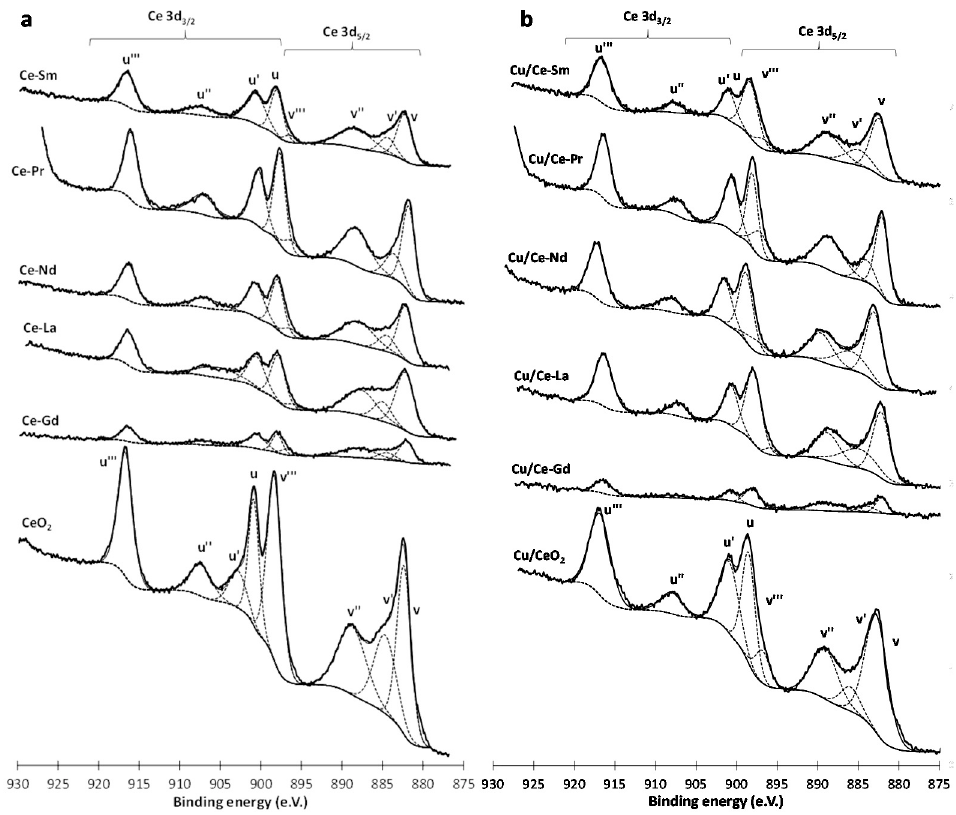
Figure 5. XPS Ce 3d spectra of Ce-Ln ( a ) and Cu/Ce-Ln ( b ) samples (Ln: Gd, La, Pr, Nd, Sm).